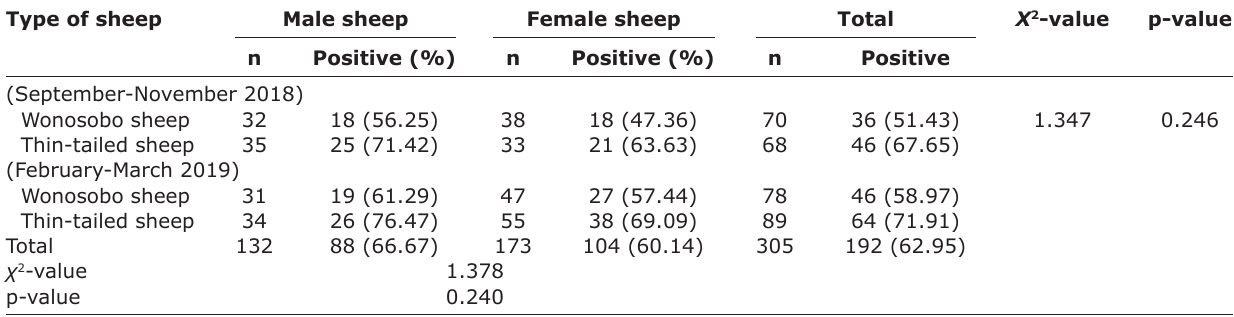
Table-1: Prevalence of gastrointestinal nematodiasis parasites in sheep. Type of sheep